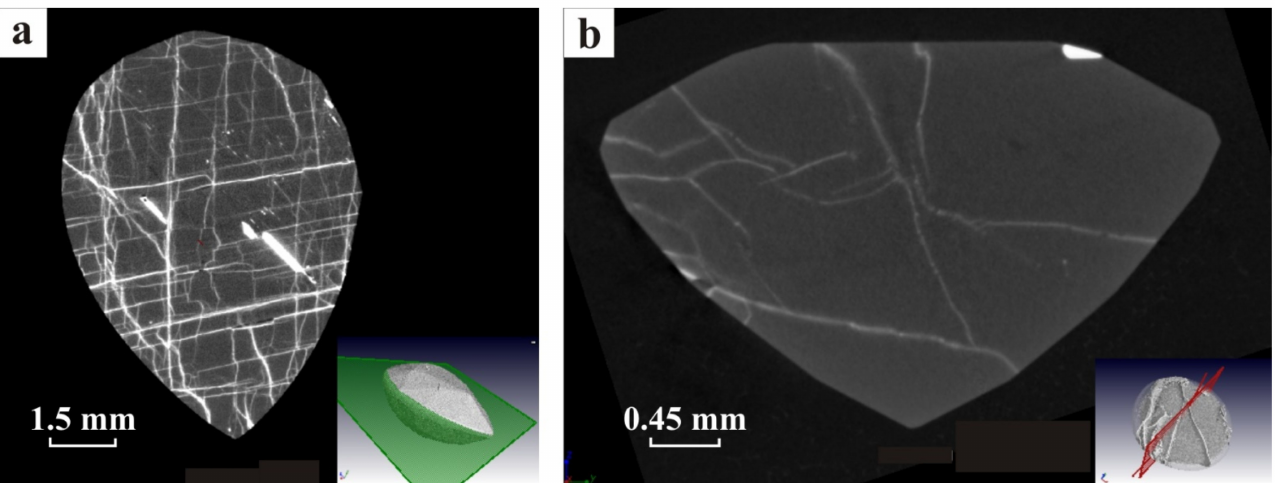
Figure 3. CT-scan section images of the fracture filled rubies, illustrating the less dense host ruby material in grey and the more dense filling material in white to light grey. Position of section planes are shown on the 3D image. ( a ) The 5 µ m resolution scan of the EGL ruby, displays a regular grid pattern of fractures related to the natural cleavage/parting planes of the mineral. ( b ) The 7.5 µ m resolution scan of the m glass-filled ruby displays a random orientation of the